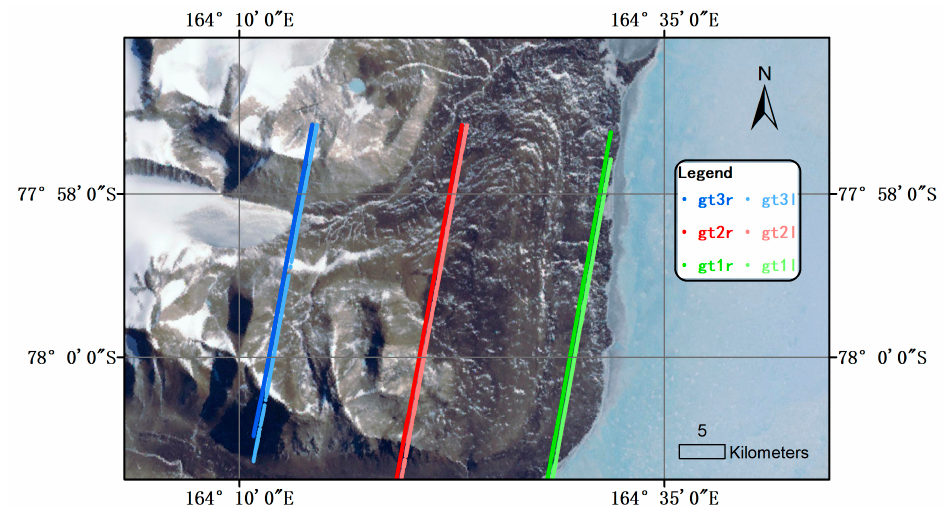
Figure 4. The tracks of the ICESat-2 data. There are three pairs of beams; gt1r, gt2r and gt3r are strong beams; and gt1l, gt2l and gt3l are weak